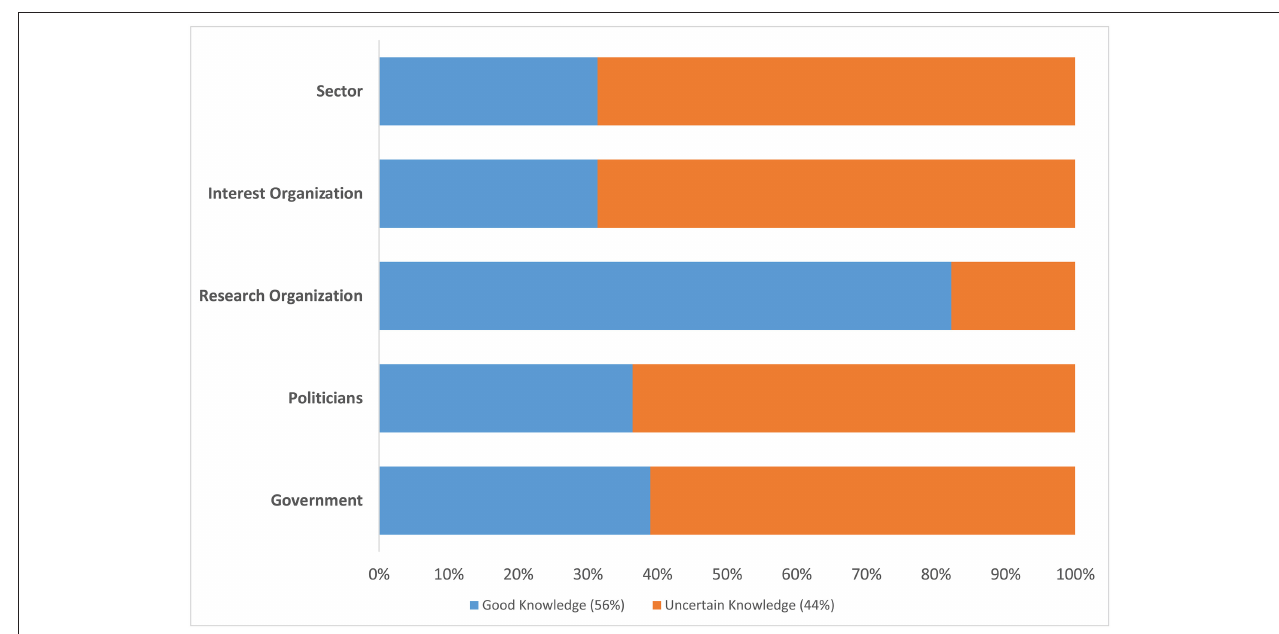
FIGURE 5 | “What is known about pollutants in sludge?” By category of stakeholder. Percentages reported represent the frequency with which an issue was mentioned across all stakeholders responding ( n =